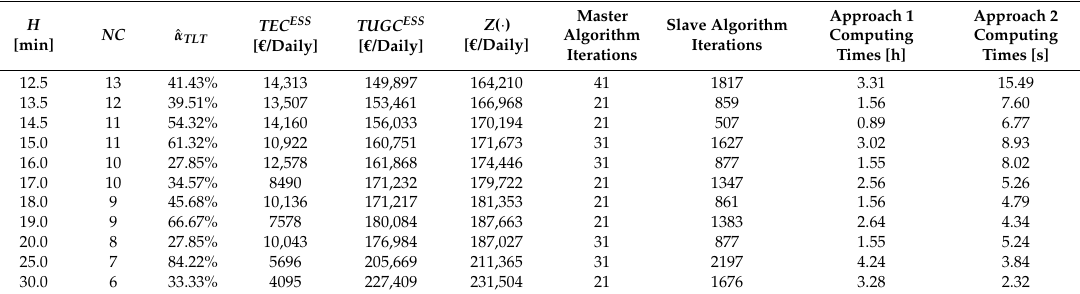
Table 9. Solution algorithm performance in the case of 95th percentile.